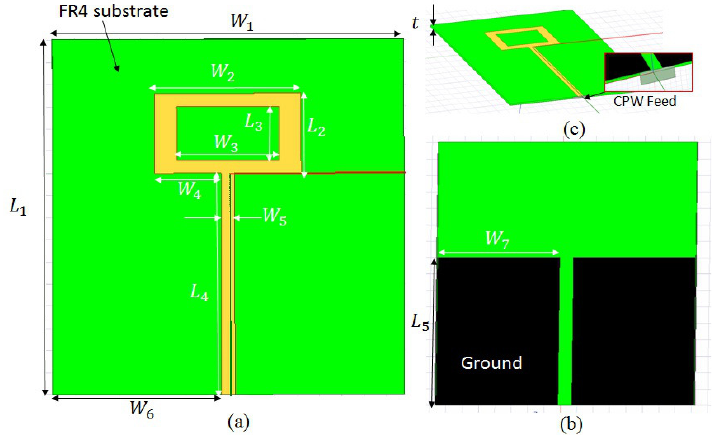
Figure 9. Designed magnetic field probe: ( a ) Top view; ( b ) Bottom view; and ( c ) 3D view ( L 1 = 80 mm, L 2 = 18 mm, L 3 = 12 mm, L 4 = 50 mm, L 5 = 45 mm, W 1 = 80 mm, W 2 = 33 mm, W 3 = 23 mm, W 4 = 15 mm, W 5 = 3 mm, W 6 = 38 mm, W 7 = 37.4 mm, and t = 1.53